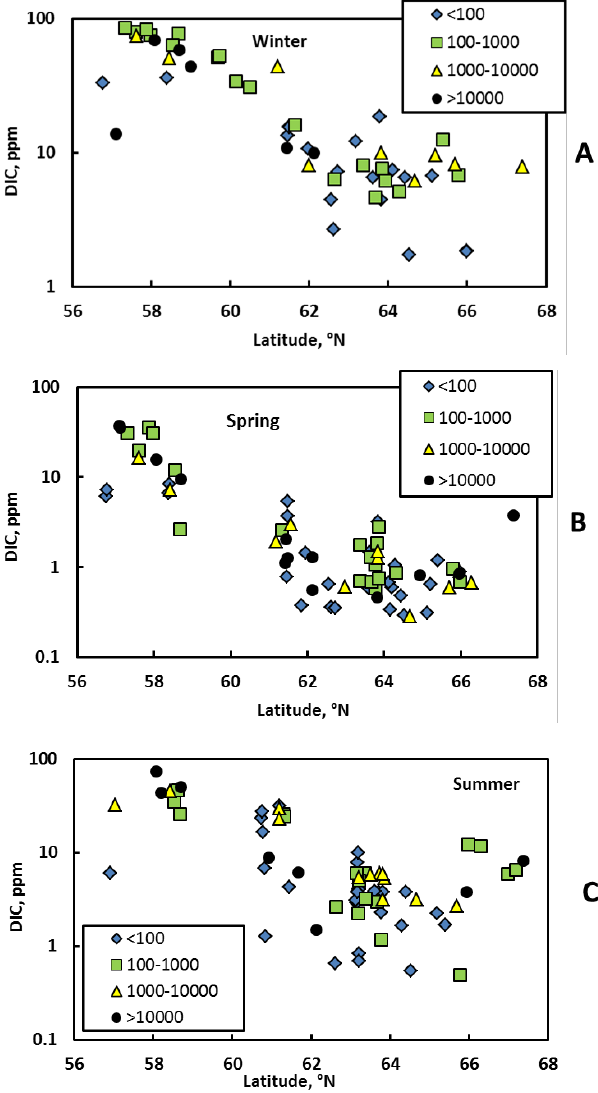
Figure 4. Significant decrease in DIC with latitude during win- ter (a) , spring (b) and summer (c) . Note the logarithmic scale on concentration in all three plots. The symbols represent different size of the watershed; see Fig. 2.